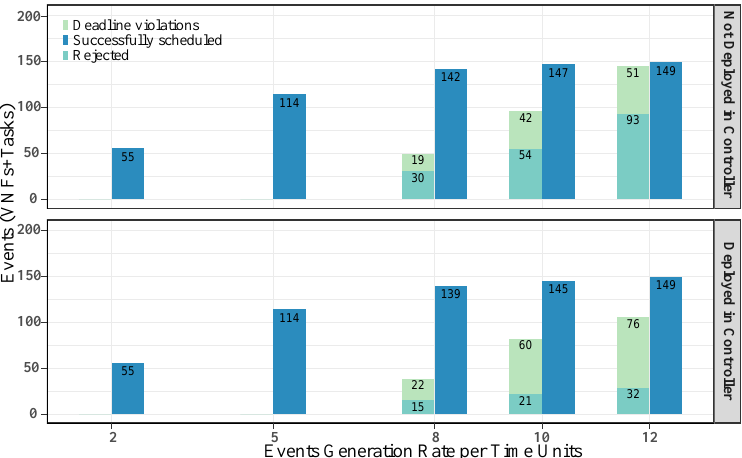
Figure 4. Number of deadline violations, rejected events and successfully scheduled events.